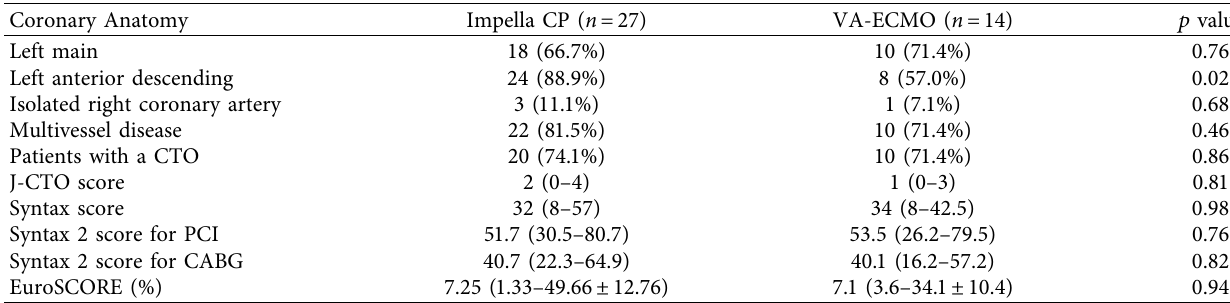
Table 2: Coronary anatomy.